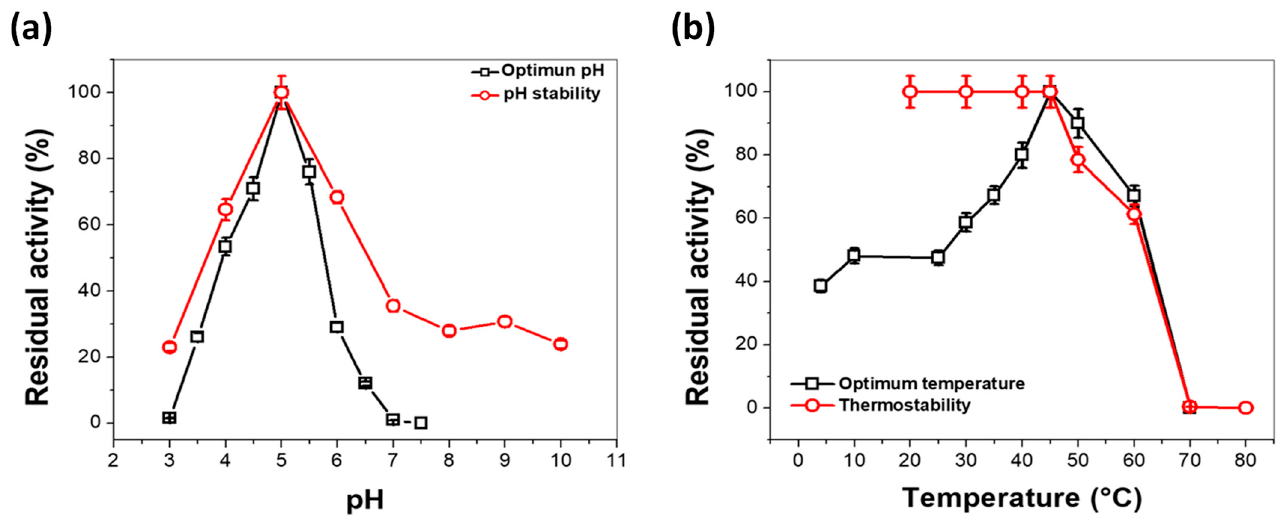
Figure 5. Determination of optimum pH and thermostability for the activity of the laccase protein purified from A. pediades . ( a ) Evaluation of laccase activity at different pH (black boxes) and stability (red circles). ( b ) Effect of temperature on the activity (black box) and stability (red circle). Error bars indicate the mean ± standard deviation of the triplicate values. Table 2. Properties of laccase enzymes purified from fungi of the Agaricales order.